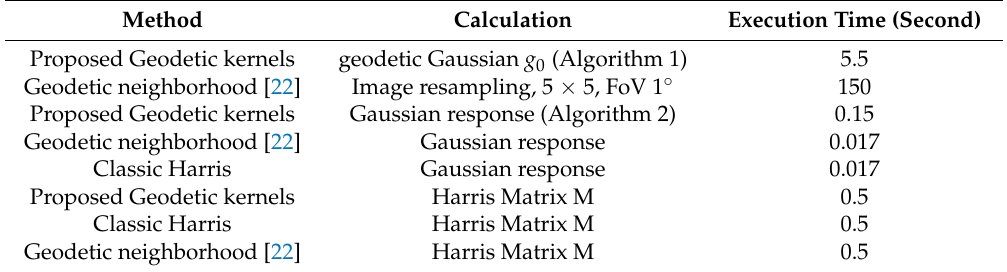
Table 3. Execution times for the proposed method, corner detection in [22] and classic corner